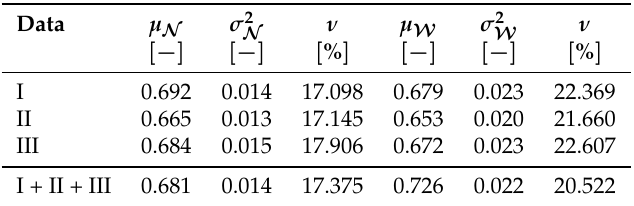
Table 4. Expectancy value ( µ ) and variance ( σ 2 ) of W EIBULL ( W )- and normal ( N )-distribution approximation of the random variable FVC ( φ m